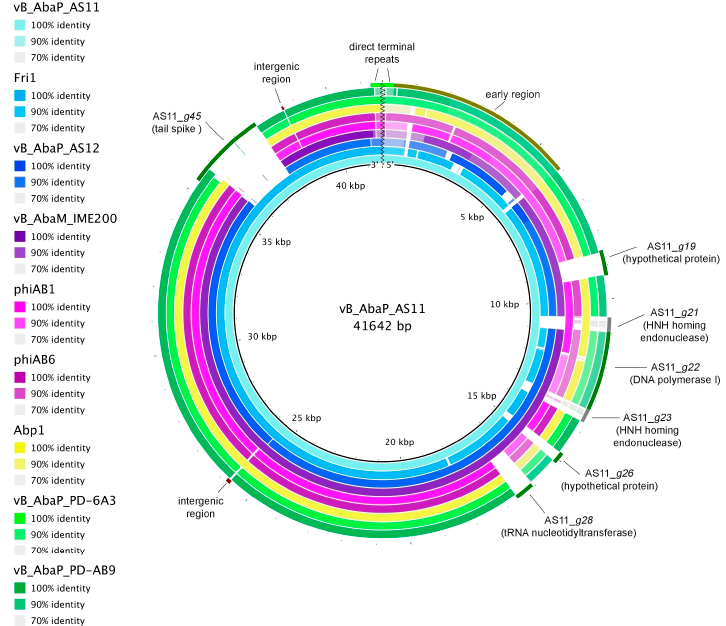
Figure 4. Comparative genome analysis of all known to date Fri1-like viruses. Reference: A. baumannii phage vB_AbaP_AS11 genome. Query: complete genome sequences of related A. baumannii podoviruses, listed in the key left. The DNA regions of AS11 genome that differ from other phages are marked. Map includes divider line showing genomes are linear.